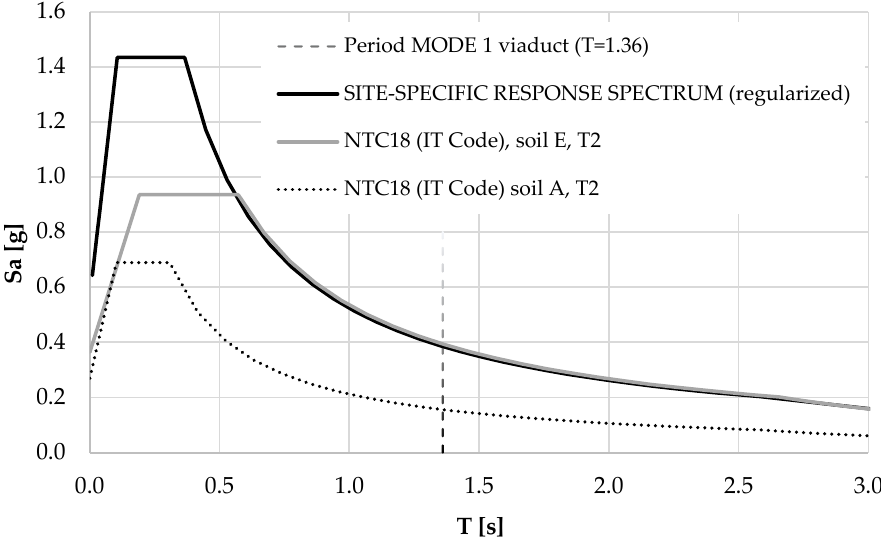
Figure 5. Graphic results of SSRS calculation according to the procedure described through seven steps.